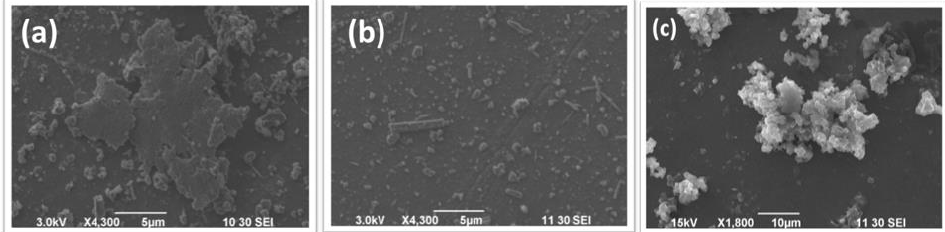
Figure 5. SEM micrographs ( a ) PANI/g-OCN, ( b ) PANI/g-POCN and ( c ) Free PANI.